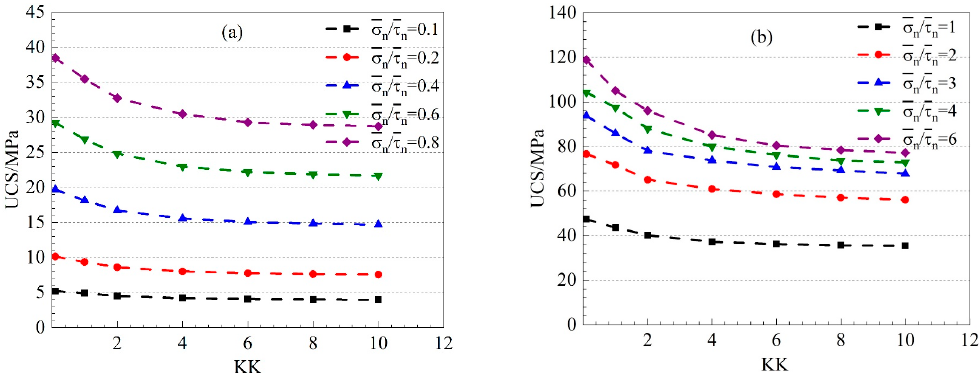
Figure 4. Relationships between bond normal-to-shear stress ratio ( σ n / τ n ) and sti ff ness ratio coe ffi cient (KK) versus uniaxial compressive strength (UCS). ( a ) σ n / τ n < 1, ( b ) σ n / τ n > 1.